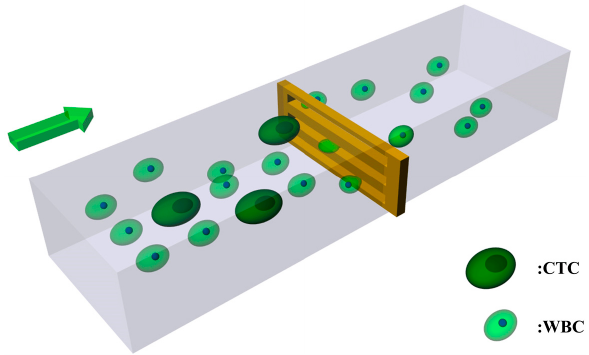
Figure 1. Schematic diagram of the filtering process.